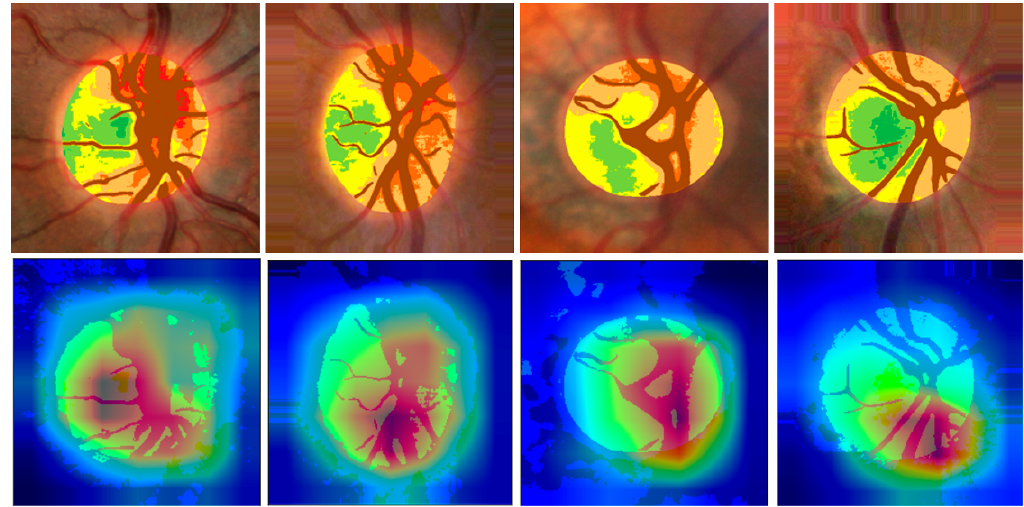
Figure A2. ( Top ): Pseudo-colour images of haemoglobin distribution in two normal optic discs (left) and two glaucomas (right) and the normalised environment, which are used for network training. The eyes are always analysed with the temporal region to the left. ( Below ): The Gradient-weighted Class Activation Maps, known as Grad-CAM saliency map, or heat maps, indicate that the networks seem to be particularly focused on the cup and the upper and lower poles.